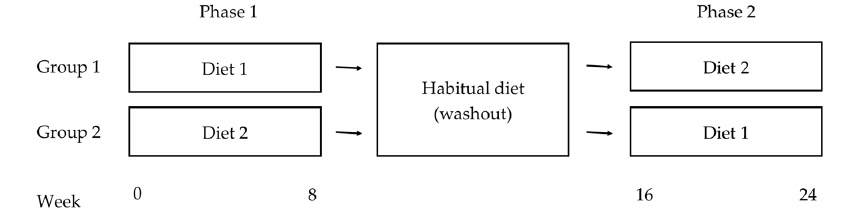
Figure 1. Crossover design.